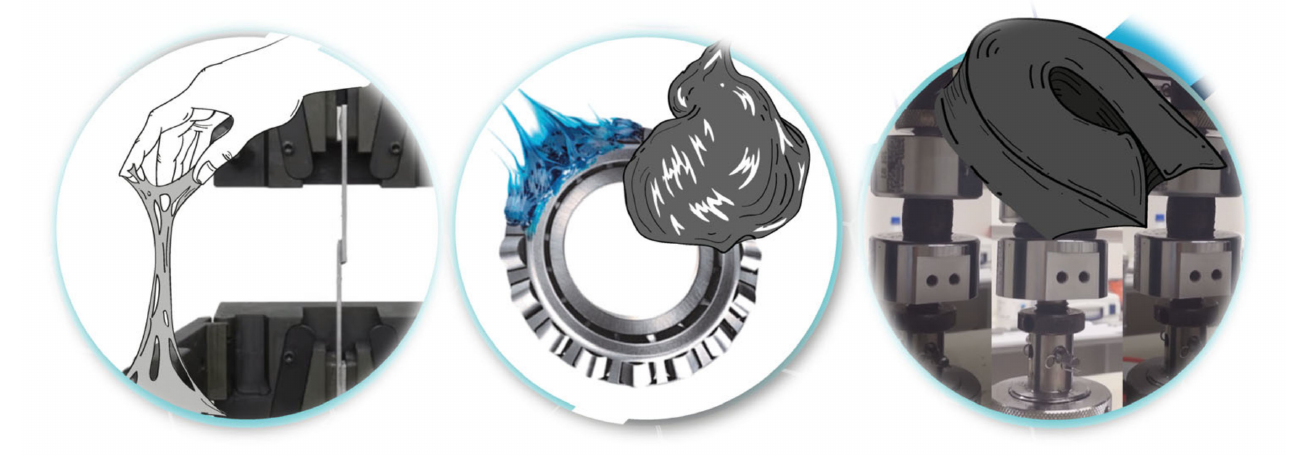
Figure 4. Main bio-polyurethanes studied, i.e., adhesives, lubricating greases and elastomers, from left to right, with testing or application as